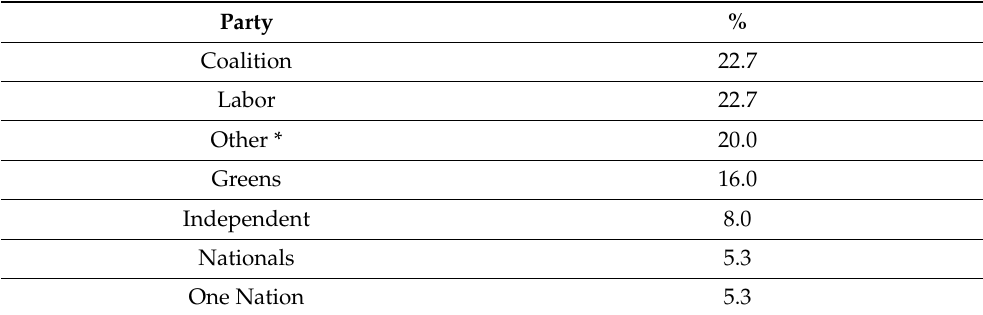
Table 6. Younger men’s voting preference for future election ( n =